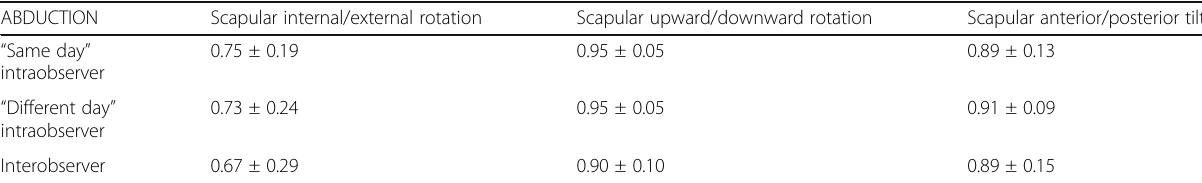
Table 3 CMC values for reproducibility of the scapular angles during shoulder abduction. The data is presented as mean ± standard deviation. Most measurement presented very good reproducibility (CMC > 0.75) with acceptable results for intra-observer agreement